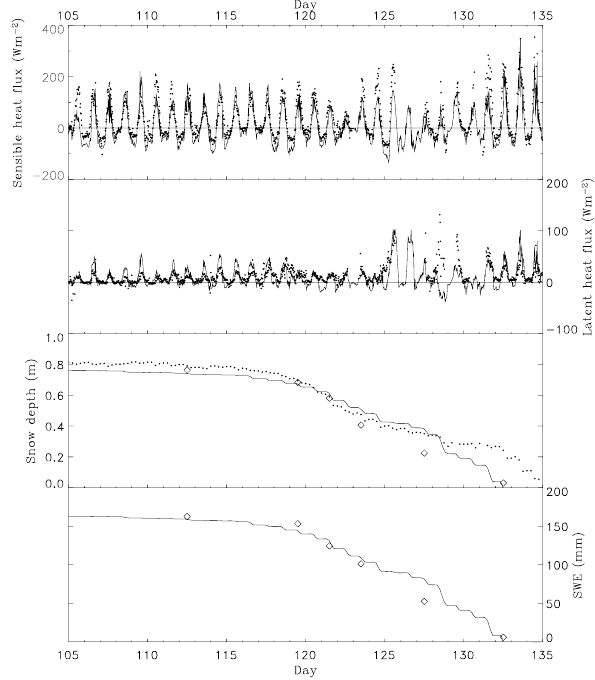
Fig. 9. As Fig. 6, but for the valley site in